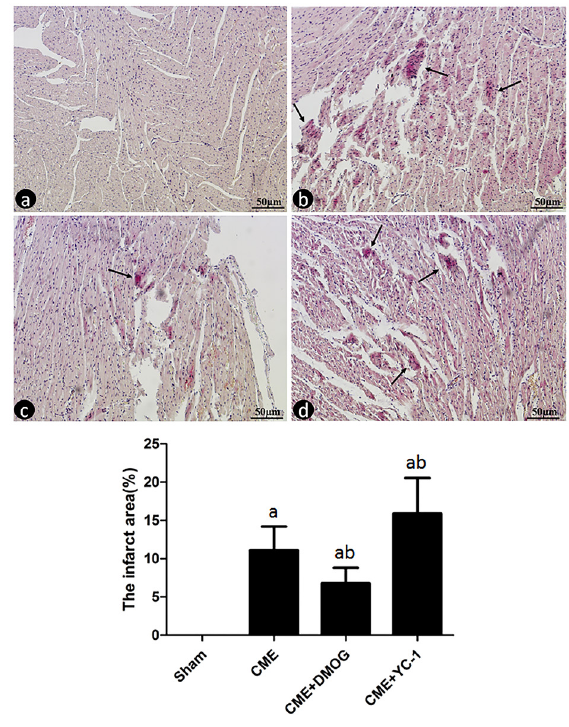
Figure 2. Pathohistological examination by HBFP staining (magnification, ×200; bar = 50 μm) Ischemic myocardium in red. Arrow indicates microinfarct area. a : HBFP staining showed no microinfarct in the Sham group; b : Infarct was evident following coronary microembolization; c : The increase was inhibited by DMOG; d : YC-1 aggravates these effects. a P <0.05 in comparison to Sham group; b P <0.05 in comparison to CME group. n =